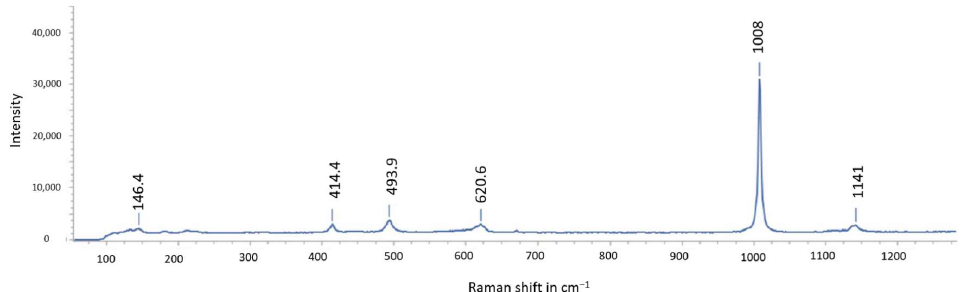
Figure 16. Raman spectrum acquired from a crystal formed on the top of jarosite from Stefføya. Gypsum is confirmed.